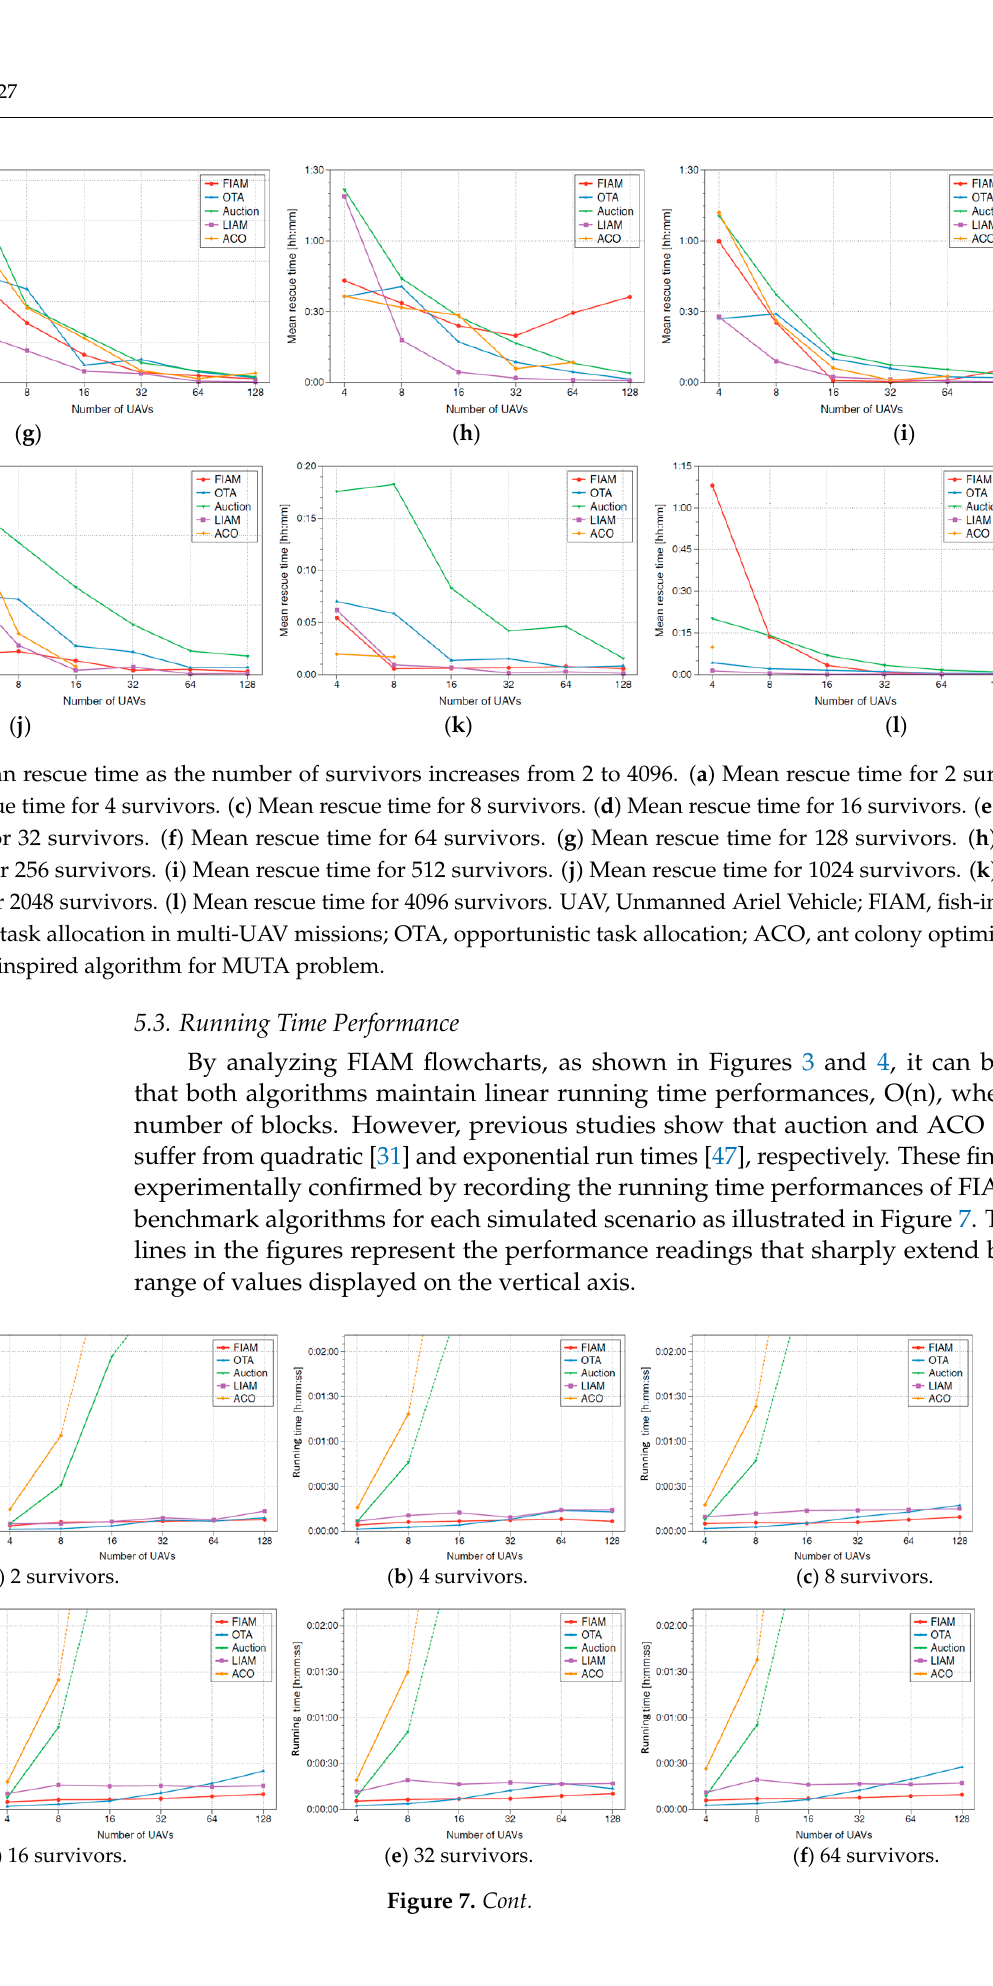
Figure 6. Mean rescue time as the number of survivors increases from 2 to 4096. ( a ) Mean rescue time for 2 survivors. ( b ) Mean rescue time for 4 survivors. ( c ) Mean rescue time for 8 survivors. ( d ) Mean rescue time for 16 survivors. ( e ) Mean rescue time for 32 survivors. ( f ) Mean rescue time for 64 survivors. ( g ) Mean rescue time for 128 survivors. ( h ) Mean rescue time for 256 survivors. ( i ) Mean rescue time for 512 survivors. ( j ) Mean rescue time for 1024 survivors. ( k ) Mean rescue time for 2048 survivors. ( l ) Mean rescue time for 4096 survivors. UAV, Unmanned Ariel Vehicle; FIAM, fish-inspired algorithm for task allocation in multi-UAV missions; OTA, opportunistic task allocation; ACO, ant colony optimization; LIAM, locust-inspired algorithm for MUTA